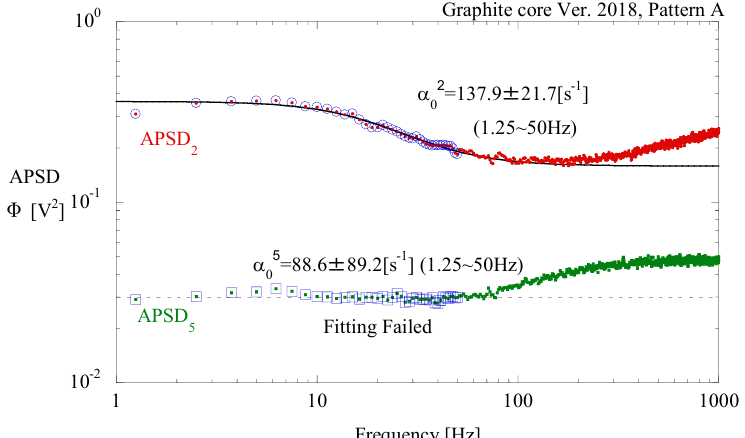
Figure 5. Auto - power spectral density from B2 and B5 in rod pattern A (subcritical